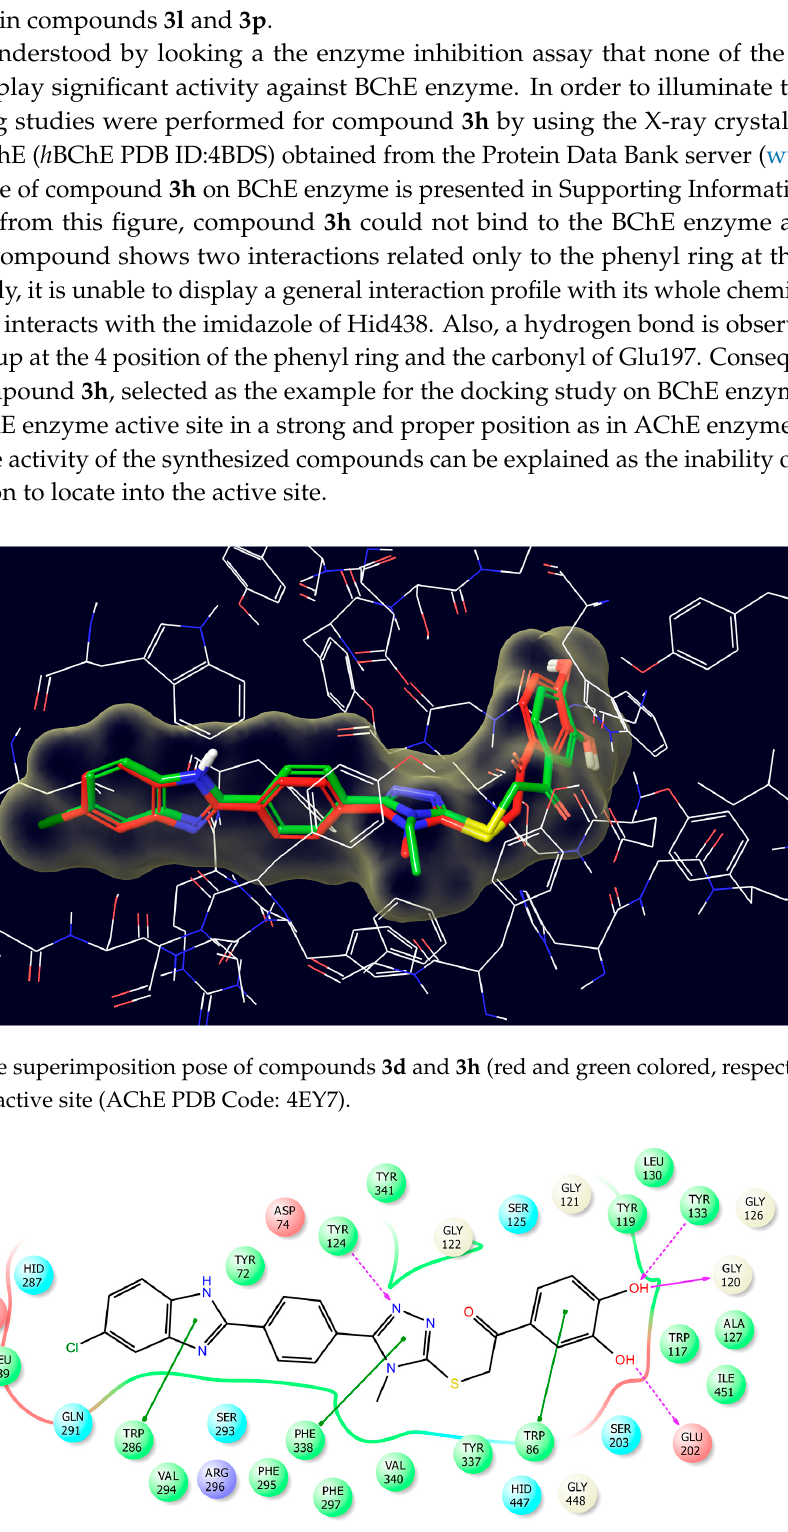
Figure 5. The interacting mode of compound 3d in the active region of AChE. The inhibitor, colored with red, and the important residues, colored with white, in the active site of the enzyme are presented by tube model. Figure 6. Two-dimensional interaction mode of compound 3h in the enzyme active site of AChE. Figure 7. The interacting mode of compound 3h in the active region of AChE. The inhibitor, colored with green, and the important residues, colored with white, in the active site of the enzyme are presented by tube model. 3. Materials and Methods 3.1. Chemistry All chemicals used in the study were purchased either from Sigma-Aldrich (St. Louis, MO, USA) or Merck KGaA (Darmstadt, Germany), and used without further chemical or biological purification. Microwave syntheses were realized by using a Monowave 300 high-performance microwave reactor